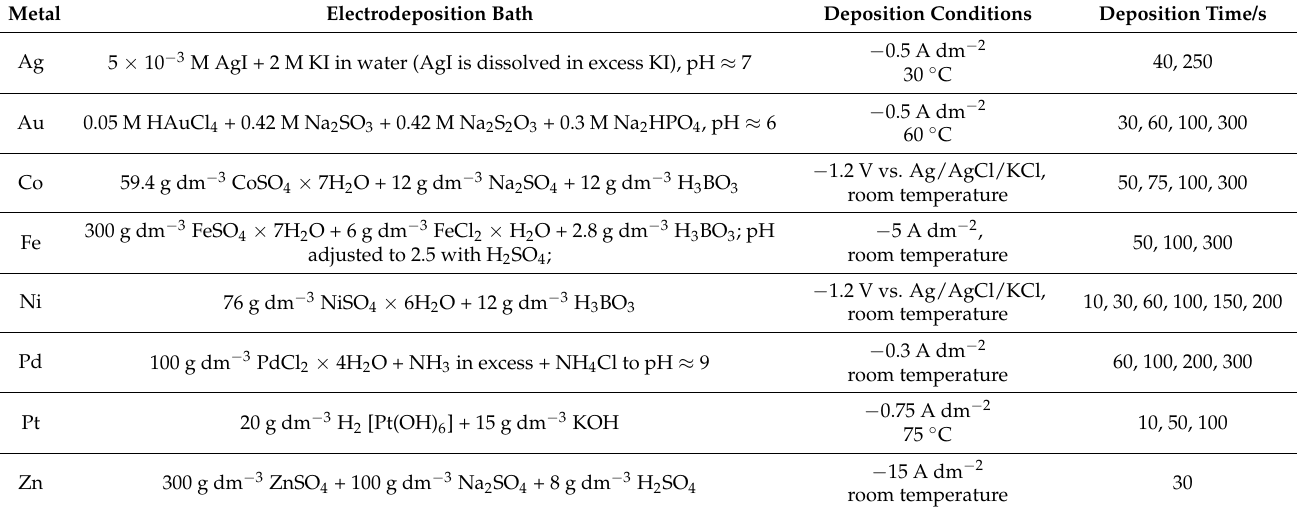
Table 1. Experimental conditions for electrodeposition of M and M@rGO electrodes. All the chemicals were of p.a. grade and were not subjected to additional